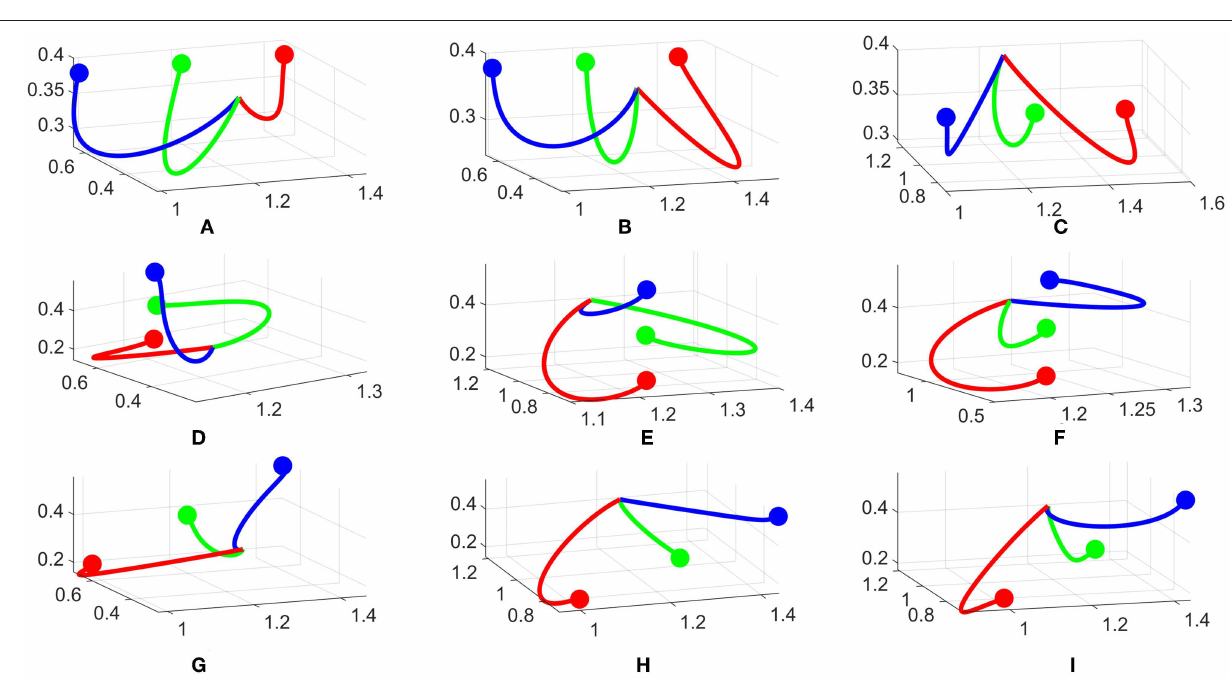
Figure 6A . Another variance is the length of the trajectories, e.g., the red line is the shortest in Figure 6A and longest in Figure 6B . All trajectories tend to go downward for all three